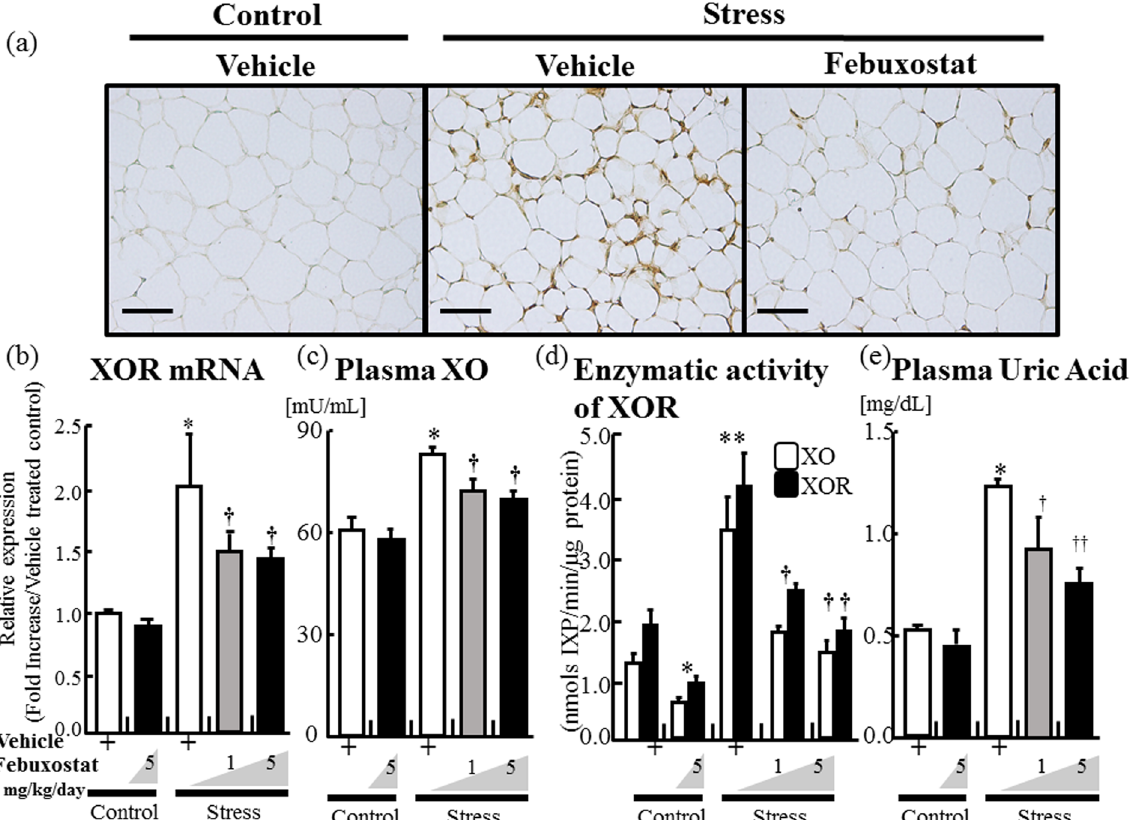
Figure 1. Febuxostat reduces stress-induced xanthine oxidoreductase activation and plasma uric acid levels in a restraint stress murine model. Expression levels and activities of xanthine oxidoreductase (XOR) and xanthine oxidase (XO) in adipose tissues, and plasma levels of XO and uric acid were analyzed in the control (non- stressed) and stressed mice treated with or without febuxostat (1 or 5 mg/kg/day), by immunohistochemistry, RT-PCR, ELISA, and XOR activity assay respectively. ( a ) Representative pictures of XO staining of adipose tissues ( × 200 magnification, bar = 50 µ m). ( b ) XOR mRNA expression in adipose tissue. Data were analyzed by Student’s t-test and displayed as mean ± SD of 7 mice per group. * P < 0.001, compared with the vehicle-treated control mice, † P < 0.001, compared with the vehicle-treated and stressed mice. ( c ) Plasma levels of XO. Data were analyzed by Student’s t-test and displayed as mean ± SD of 7 mice per group. * P < 0.001 compared with the vehicle-treated control mice, † P < 0.03, compared with the vehicle-treated and stressed mice, respectively. ( d ) XO and XOR (XO + XDH) enzymatic activity in homogenized adipose tissue. Data were analyzed by Student’s t-test and displayed as mean ± SD of 5–6 mice per group. * P < 0.01 and ** P < 0.001, compared with the vehicle-treated control mice, † P < 0.004 and †† P < 0.003, compared with the vehicle-treated and stressed mice, respectively. ( e ) Levels of plasma uric acid. Data were analyzed by Student’s t-test and displayed as mean ± SD of 5–6 mice per group. * P < 0.01, compared with the vehicle-treated control mice, † P < 0.03 and †† P < 0.012, compared with the vehicle-treated and stressed mice,